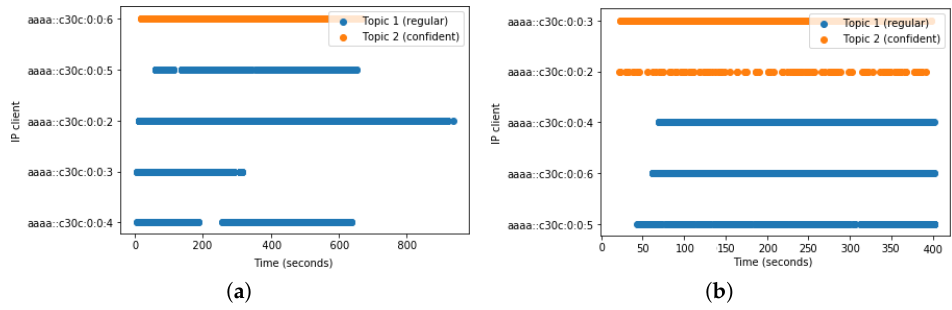
Figure 17. Spoofing connection attack evaluation diagrams. ( a ) MQTT-SN topics sent for each device in the baseline scenario. ( b ) MQTT-SN topics sent for each device after spoofing